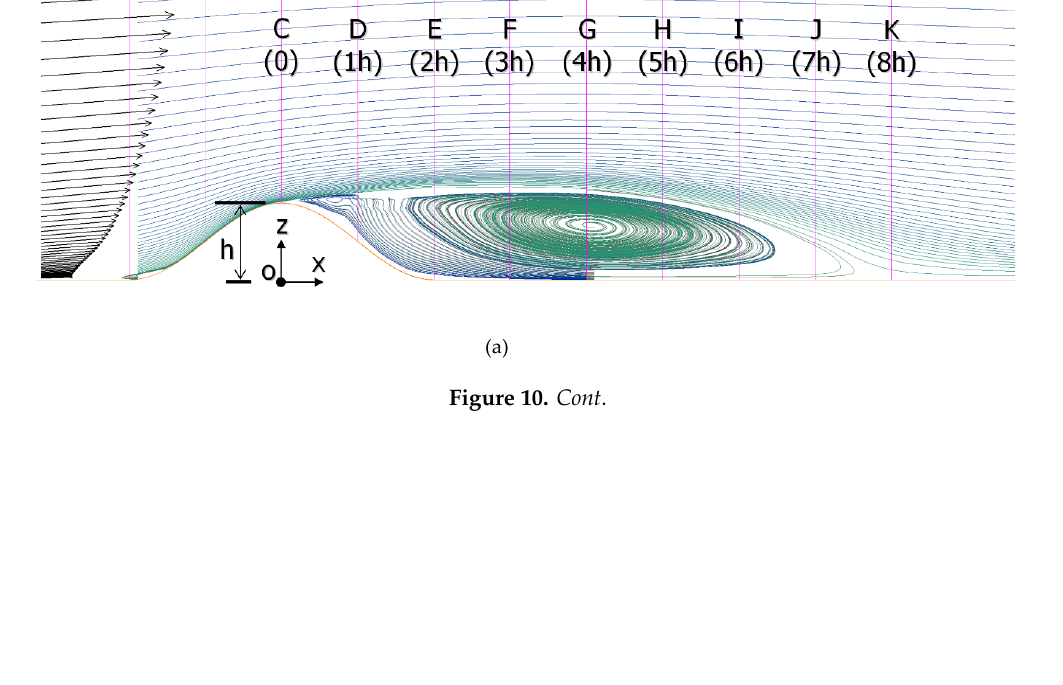
Figure 9. Streamlines for flow field with temporal and spanwise spatial averaging: (a) L = 9 h, (b) L = 27 h, and (c) L = 54 h.